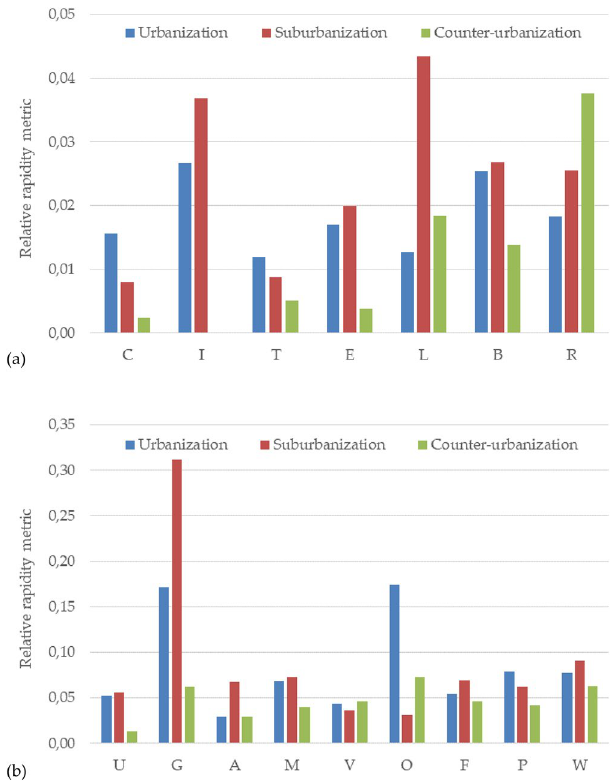
Figure 2. A relative metric of rapidity-of-change estimating ‘fast’ and ‘slow’ attributes of landscape structure ( a ) and functions ( b ), by growth stage in metropolitan Rome. Legend and acronyms: landscape structure (‘C’ = core, ‘I’ = Islet, ‘T’ = Perforation; ‘E’ = Edge; ‘L’ = Loop; ‘B’ = Bridge; ‘R’ = Branch); landscape functions (‘U’ = Built-up area; ‘G’ = Green urban area; ‘A’ = Arable land; ‘M’ = Crop mosaic; ‘V’ = Vineyards; ‘O’ = Olive groves, ‘F’ = Woodland; ‘P’ = Pastures; ‘W’ =